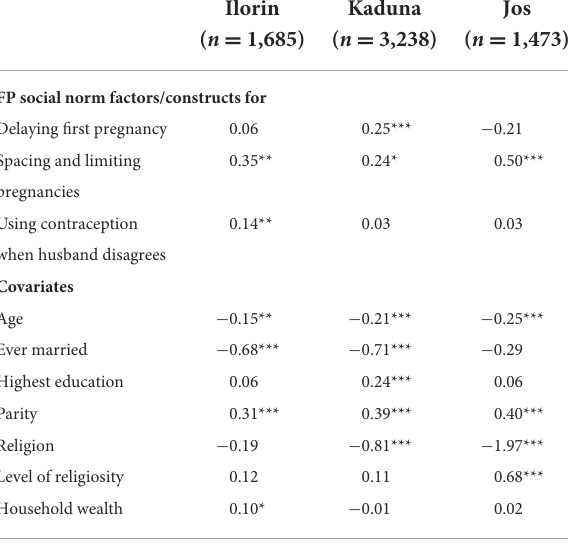
TABLE 5 Path coefficients by study location for structural equation model for association of family planning social norms with current use of modern contraceptive methods among women who ever had sex, Nigeria,